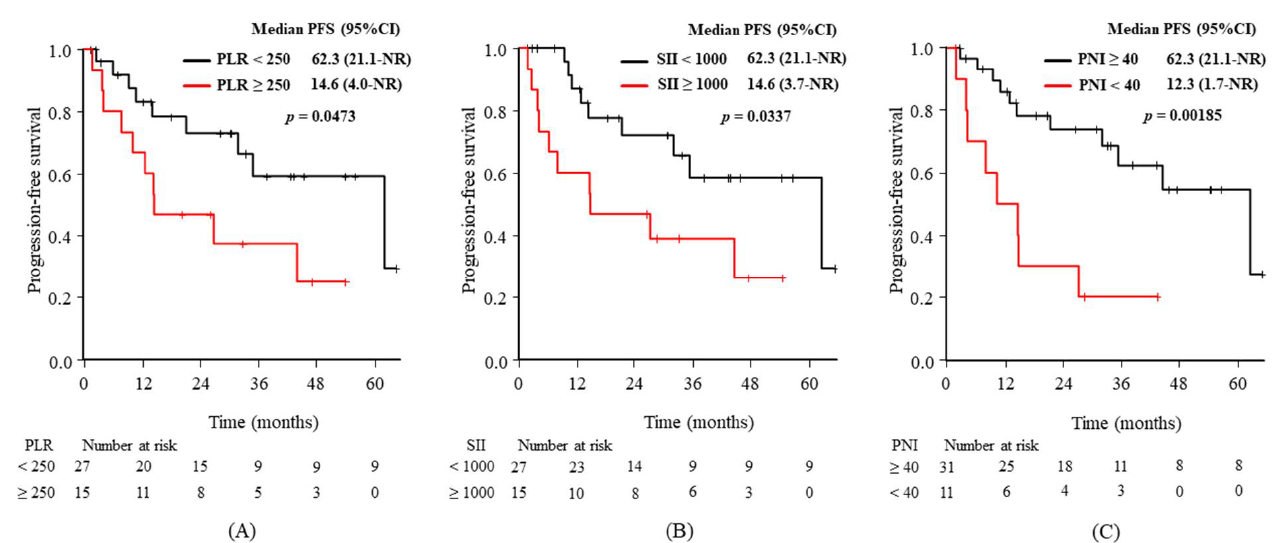
Figure 2. Kaplan–Meier curves of progression-free survival (PFS) according to the baseline values for ( A ) platelet-to- lymphocyte ratio (PLR), ( B ) systemic immune-inflammation index (SII), and ( C ) prognostic nutrition index (PNI). Longer median PFS values were associated with a PLR of <250, an SII of <1000, and a PNI of ≥40 at baseline. CI: confidence interval, NR: not reached.